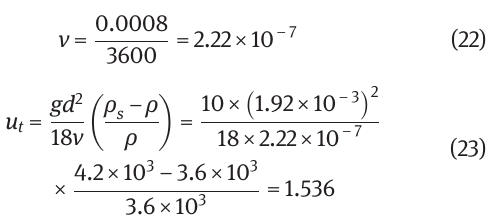
Figure 16: Diagrammatic drawing of the distributed situation of rutile in the